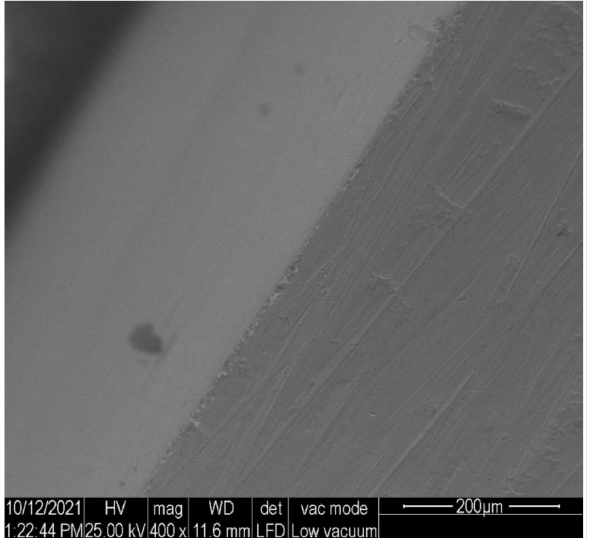
Figure 7. SEM images of the cross-sectional sandwich a sample, MnTa 2 O 6 /5,15-(4-carboxy-phenyl)-